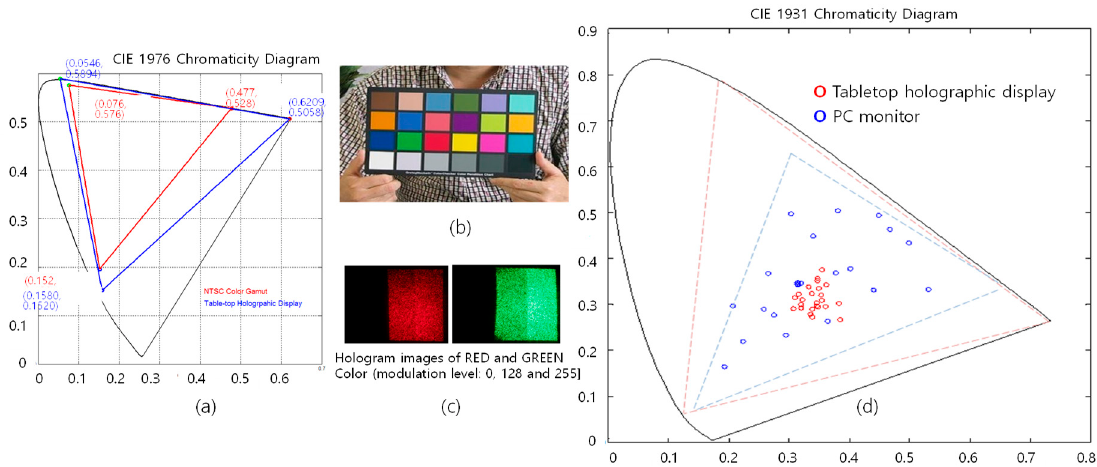
Figure 12. Color gamut and color fidelity of implemented system, ( a ) color gamut, ( b ) 24 color Gretag-Macbeth ColorChecker, ( c ) hologram image, and ( d ) measured color fidelity.